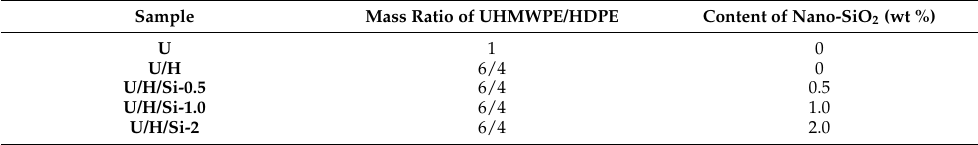
Figure 1. Schematic diagram for the surface modification process of nano-SiO 2. Table 1. The formulation of UHMWPE, HDPE and nano-SiO 2 in different samples.